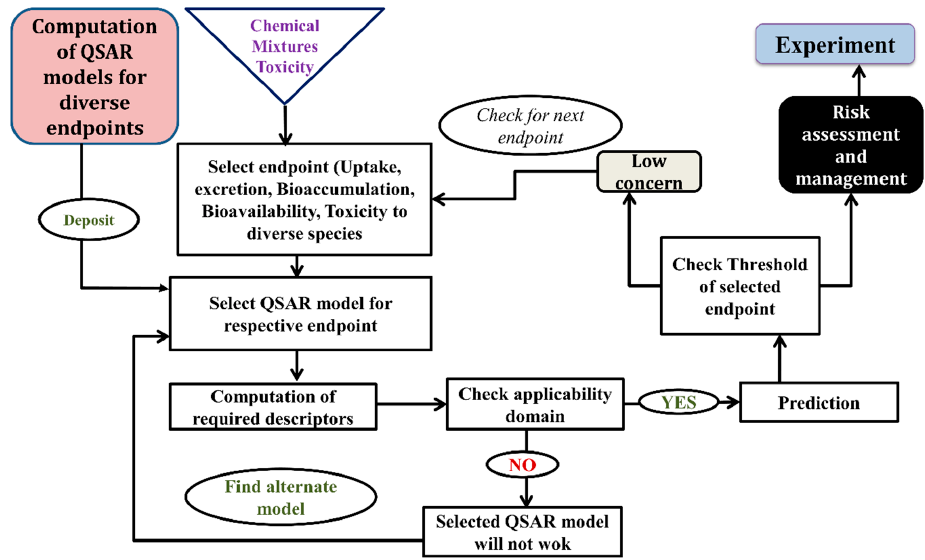
Figure 5. Flow chart to prepare QSAR-based expert